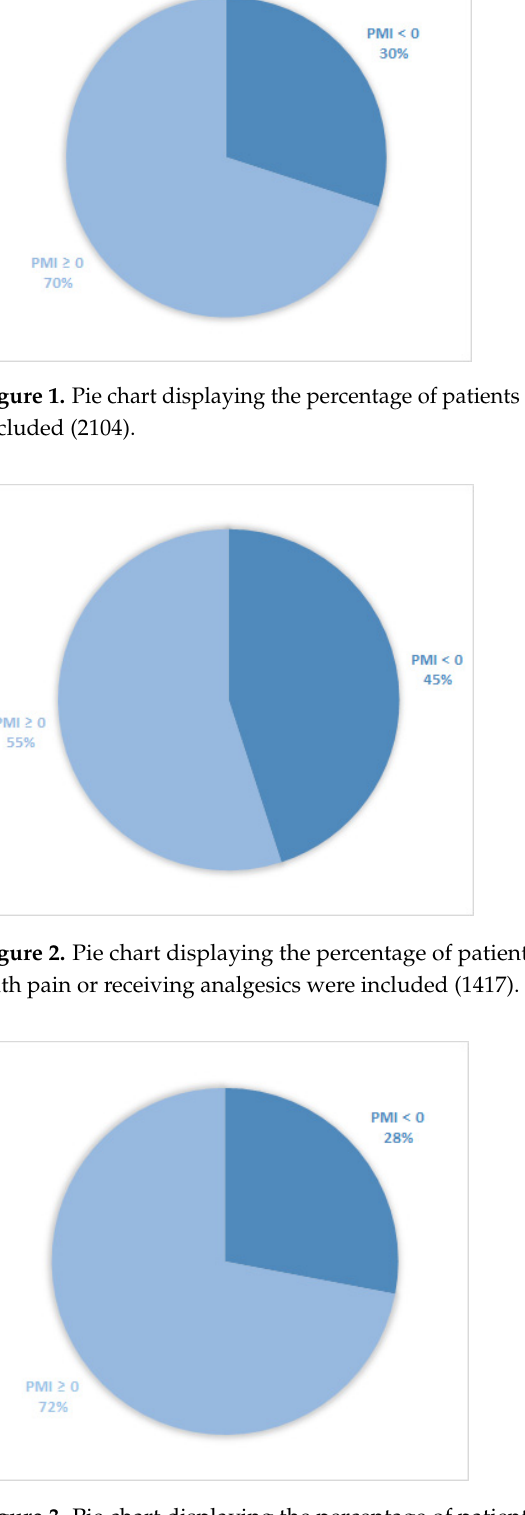
Figure 4. Pie chart displaying the percentage of patients with PMI < 0 and PMI ≥ 0. Only patients undergoing curative radiotherapy were included (1313). Figure 5. Pie chart displaying the percentage of patients with PMI < 0 and PMI ≥ 0. Only patients undergoing palliative radiotherapy and with pain or receiving analgesics were included (737).